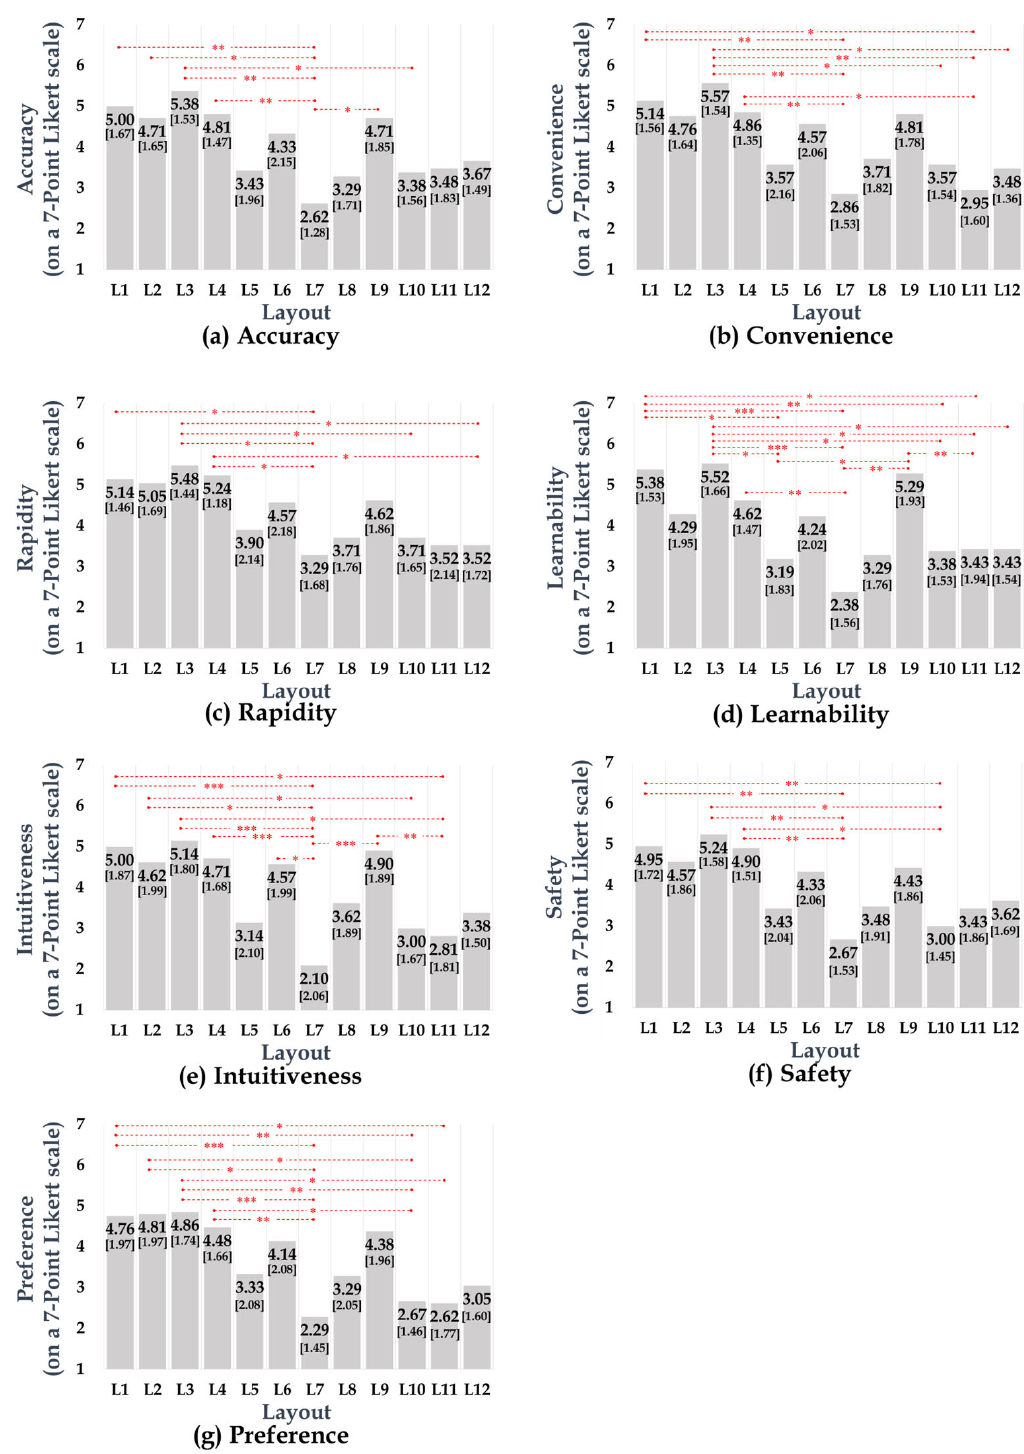
Figure 1. Mean and standard deviation of each subjective rating measure for each layout: ( a ) accuracy, ( b ) convenience, ( c ) rapidity, ( d ) learnability, ( e ) intuitiveness, ( f ) safety, and ( g ) preference. * p < 0.05, ** p < 0.01, *** p < 0.001.